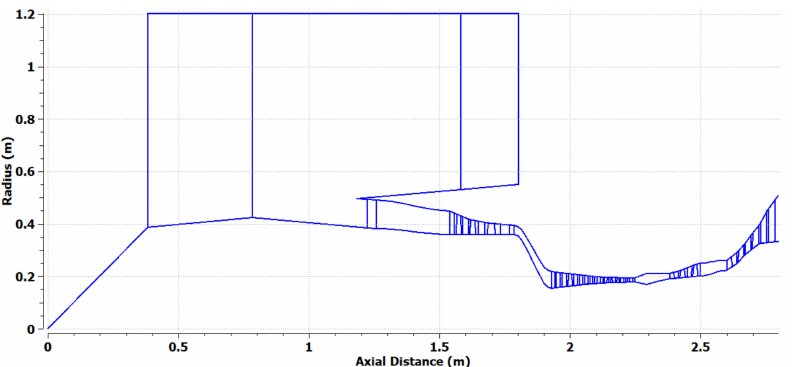
Figure 6. Main gas flowpath for the optimum engine